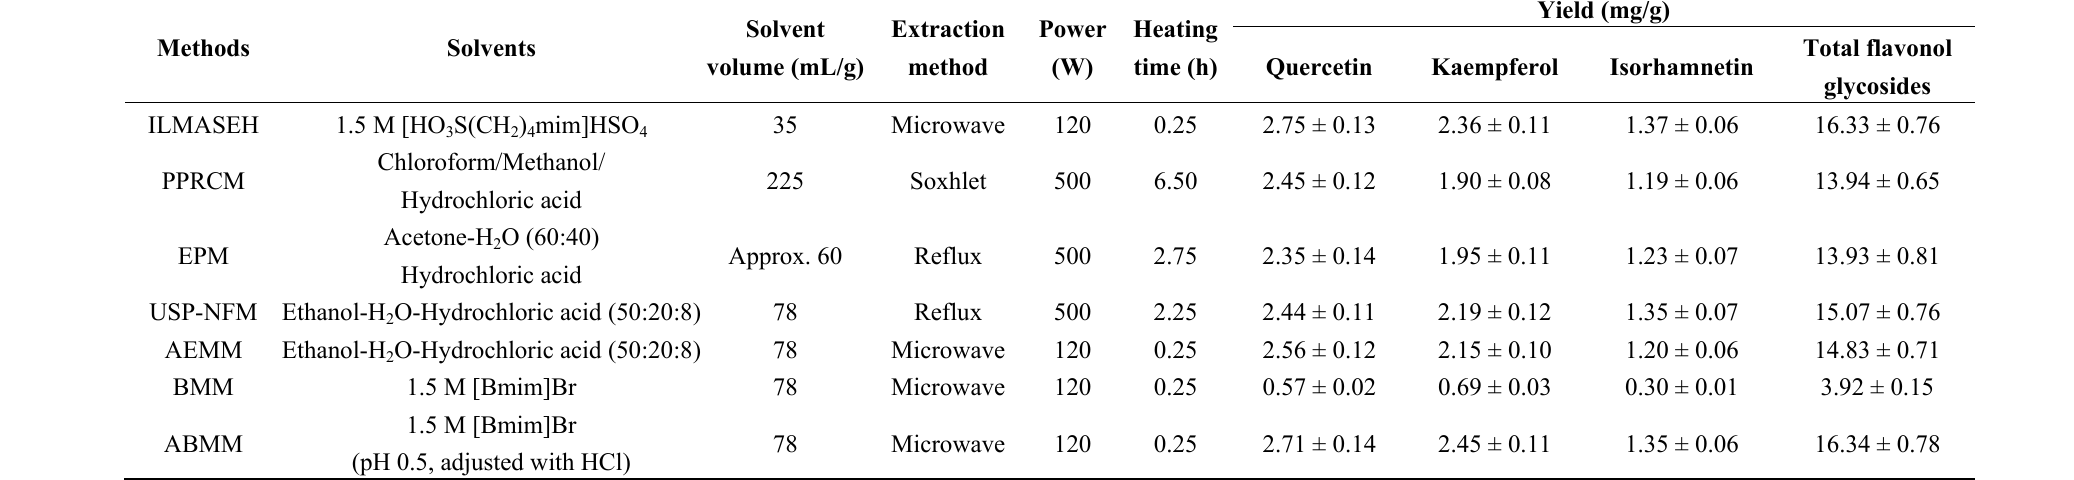
Table 1. Comparison of ILMASEH approach with reference and conventional